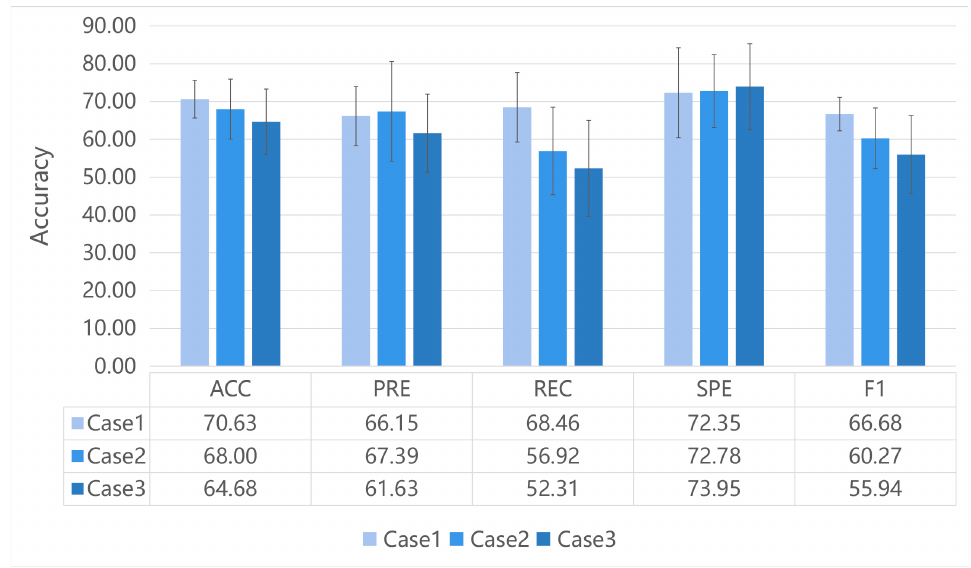
Figure 3. The results of our proposed GIN classification for different ways to construct initial graph. Case1: take the absolute values of FC as edge weights. Case2: keep the edges with positive FC. Case3: keep the original FC values as edge weights.